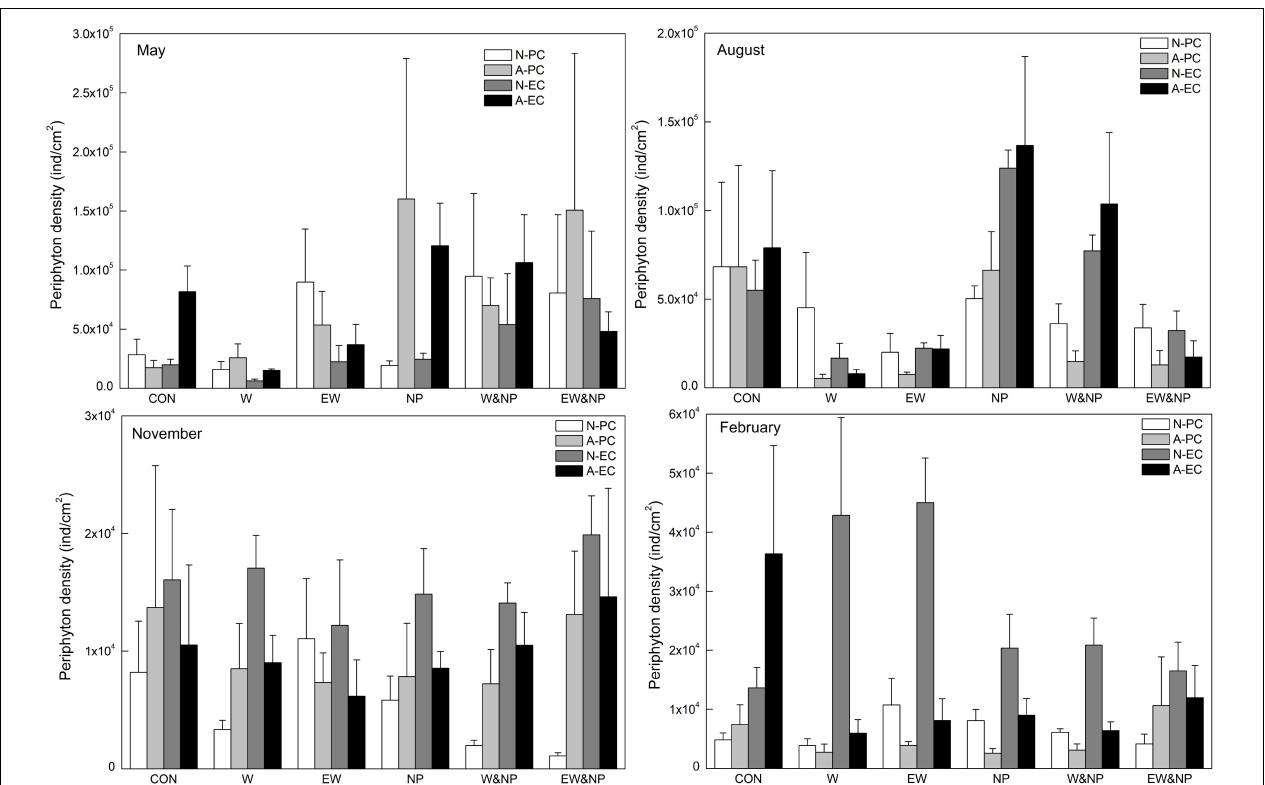
FIGURE 3 | Periphyton density on four types of plant substrate in each treatment divided into